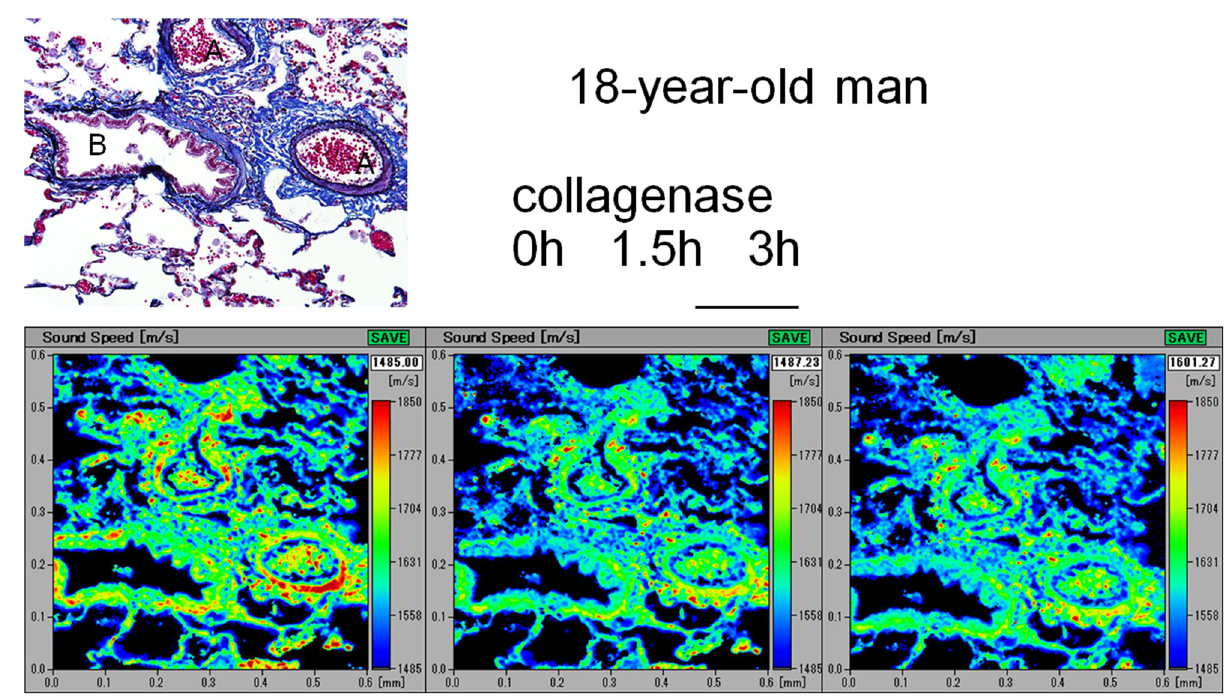
Fig 7. Alteration in SOS values of the young lung after collagenase digestion. In the young lung, SOS values of the arteriolar and bronchiolar walls and alveoli show a gradual decline after the collagenase treatment, which can be observed as a change in color indicator. The corresponding LM images of sections stained with Verhoeff’s elastic and Masson’s trichrome staining are presented in the upper left corner. A, arterioles; B, bronchioles. Scale bar = 200 μ m.